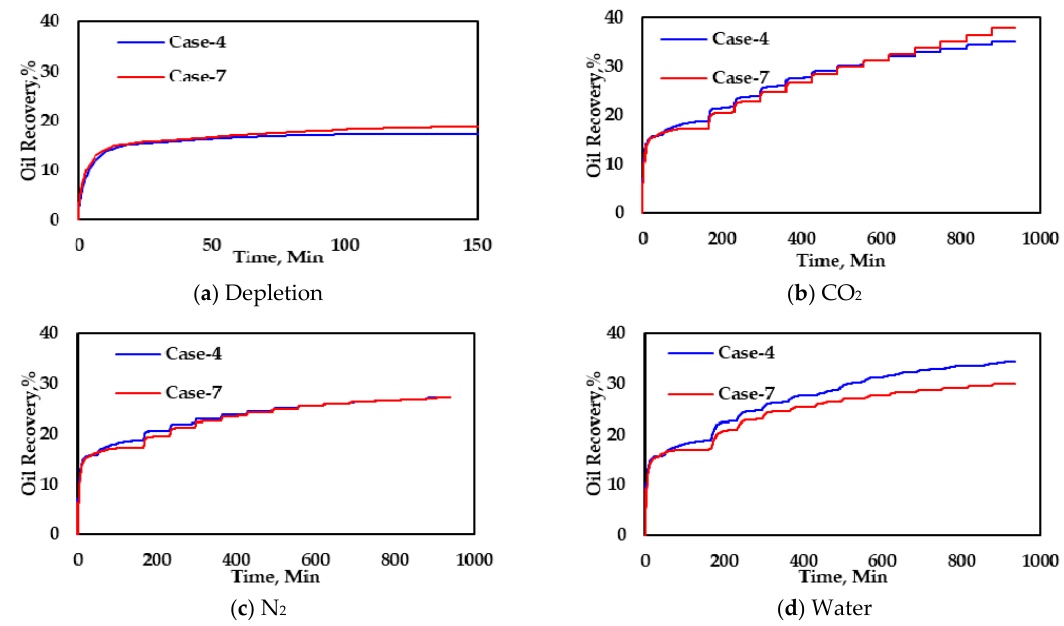
Figure 29. Oil recovery comparison between different directions of scattered fracture.